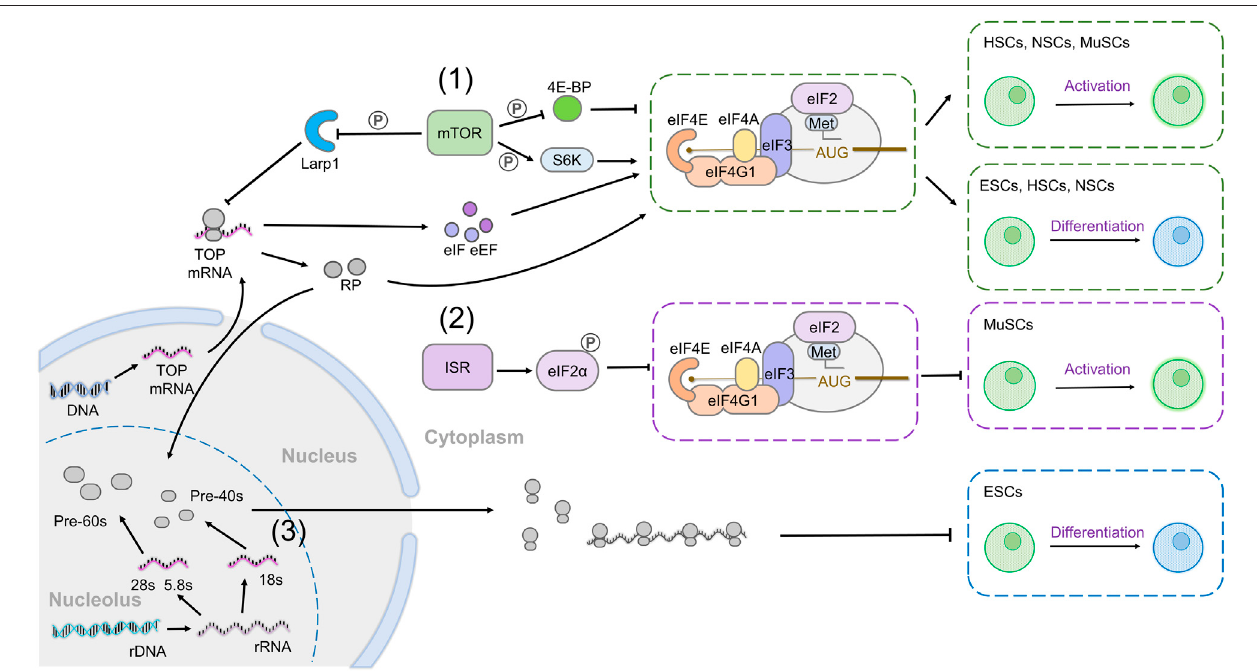
FIGURE2| Globalmechanismsoftranslationregulationandtheirrolesinstemcellmaintenance.(1)mTORactivityincreasesglobaltranslationthroughitseffectors 4E-BP and S6K and promotes cap-dependent translation. In addition, mTOR increases the translation of TOP mRNAs, which include most components of the translationmachinery including translationinitiationfactors (eIFs), translation elongation factors (eEFs), and ribosomal proteins(RPs). Increased mTOR signaling leadsto the activation of HSCs, NSCs, and MuSCs from quiescence and induces differentiation of ESCs, HSCs, and NSCs (green boxes). (2) The integrated stress response (ISR) pathway promotes eIF2 ɑ phosphorylation, which reduces eIF2 ɑ association with Met-tRNA iMet and impairs global translation. P-eIF2 ɑ prevents MuSC activation from quiescence (purple box). (3) Ribosomes are assembled in the nucleolus. Decreasing the rate of ribosome biogenesis results in ESC differentiation (blue